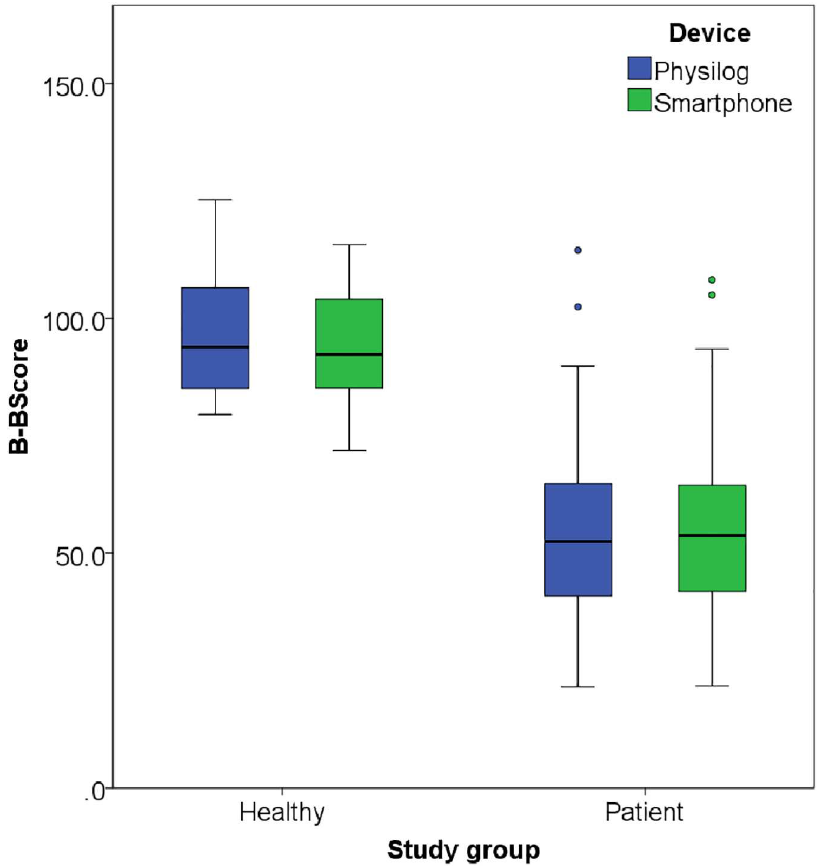
Fig 3. B-B Score outcome in both groups using the referencesystem(Physilog ® ) and the smartphone.